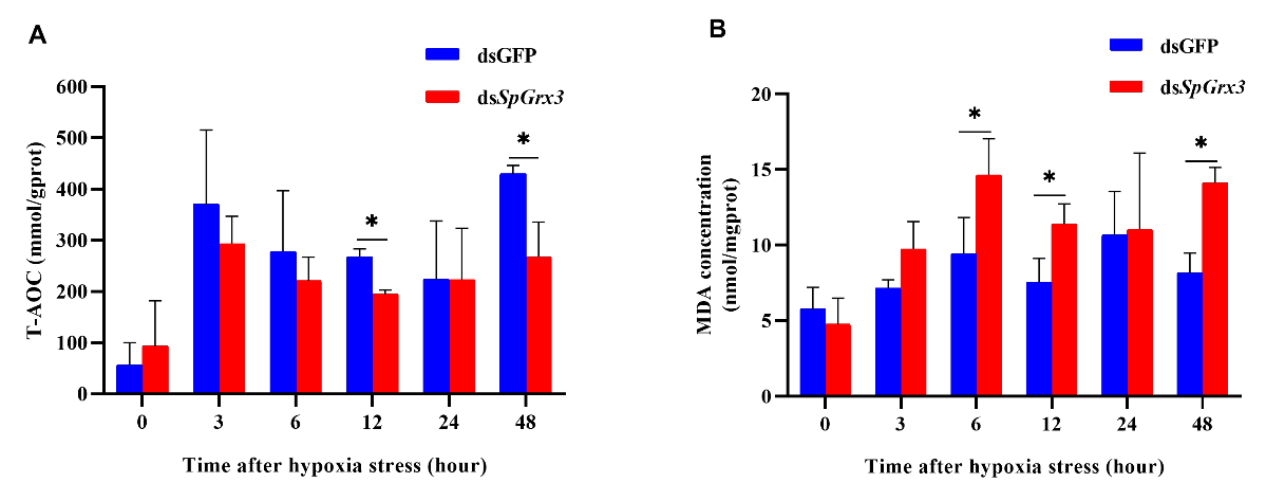
Figure 6. Functional analysis of SpGrx3 during hypoxia. T-AOC ( A ) and MDA ( B ) concentrations in the gills of SpGrx3 -interfered mud crabs after exposure to hypoxia (the dsGFP group was used as the control). The data are presented as the mean ± SD (N = 3). *: p < 0.05. The subcellular localization of SpGrx3 in S2 cells was observed using confocal laser scanning microscopy. After pAc5.1- SpGrx3 -GFP transfection into S2 cells for 48 h, the localization of pAc5.1- SpGrx3 -GFP was dispersed throughout the nucleus, suggesting that SpGrx3 protein was localized in the nucleus of S2 cells (Figure 7).